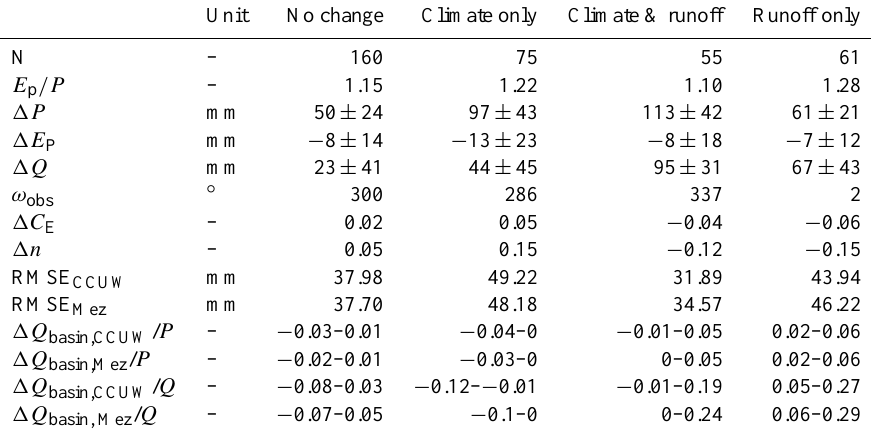
Table 3. Group average statistics of hydro-climatic changes for 4 groups of basins (“no change”, “climate only”, “runoff only” and “climate & runoff”), classified by results of a combination of two-sample t-test results grouping basins with significant change at α = 0 . 05. For the hydro-climatic changes, also the group standard deviation is given. For the normalised basin changes, the first and third quartiles are given. In total 351 basins have been tested. Unit Climate